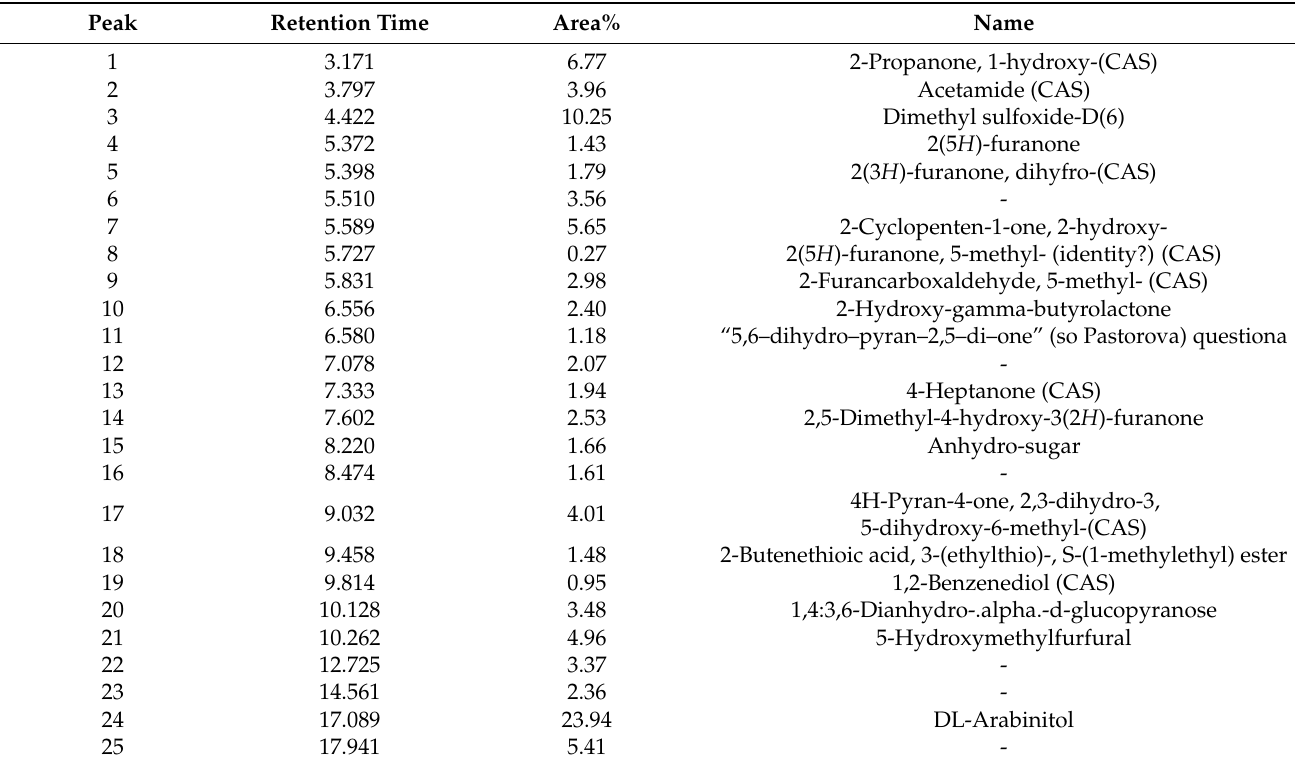
Table 2. List of compounds identified in the crude extract of G. applanatum by using GC–MS.